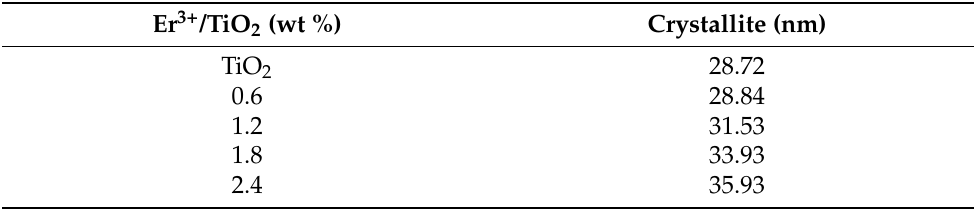
Table 2. Size of crystallite particles of all synthesized samples.